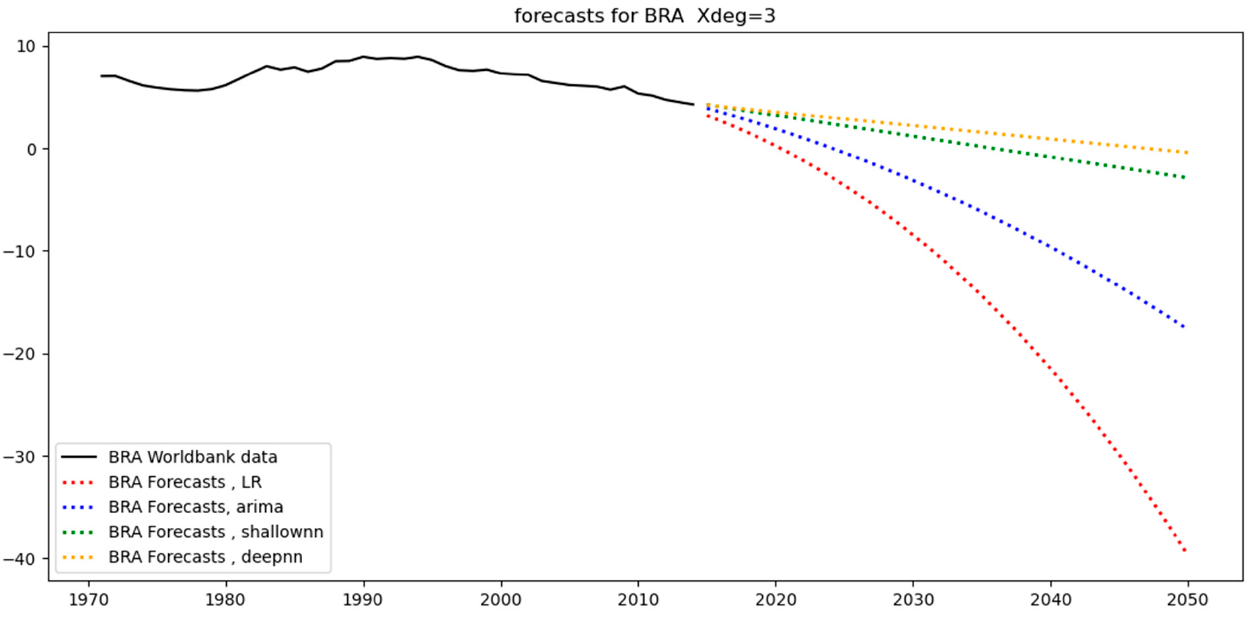
Figure 18. Forecasts for Brazil (BRA), using linear regression (LR), ARIMA, shallow neural networks (shallownn), and deep neural network (deepnn) models (third-degree polynomial).